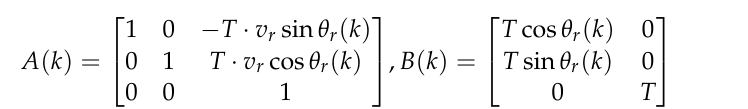
where k is the sampling time. The above model is rewritten